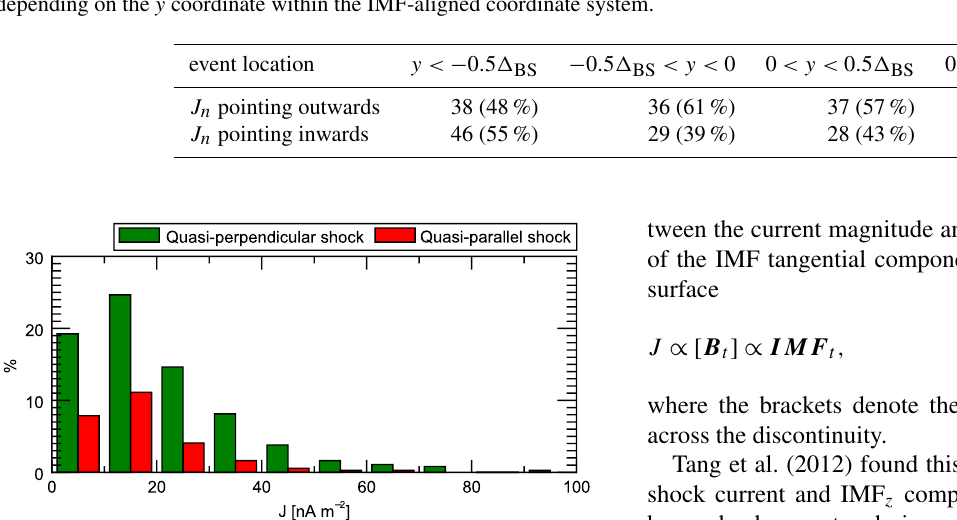
Table 1. Occurrence rate of outward- and inward-pointing directions of the current normal component at the quasi-perpendicular bow shock depending on the y coordinate within the IMF-aligned coordinate system.